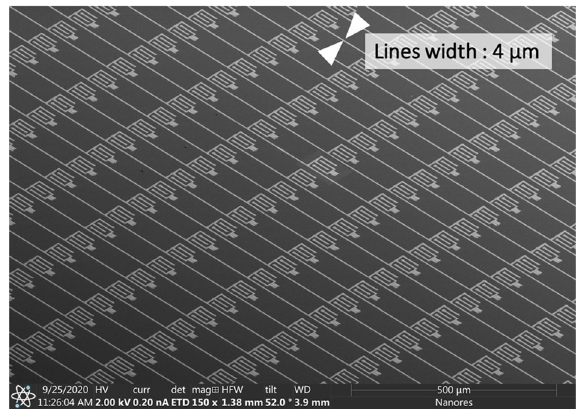
Figure 16. Demonstration of the capabilities of the UPD technology for mass production. The figure shows 7500 printed segments for a thin-film transistor array with the line width of 4 μm. The key feature of UPD in this case is not only the line width, but also the ability to reduce the interline distance to single micrometers and below.